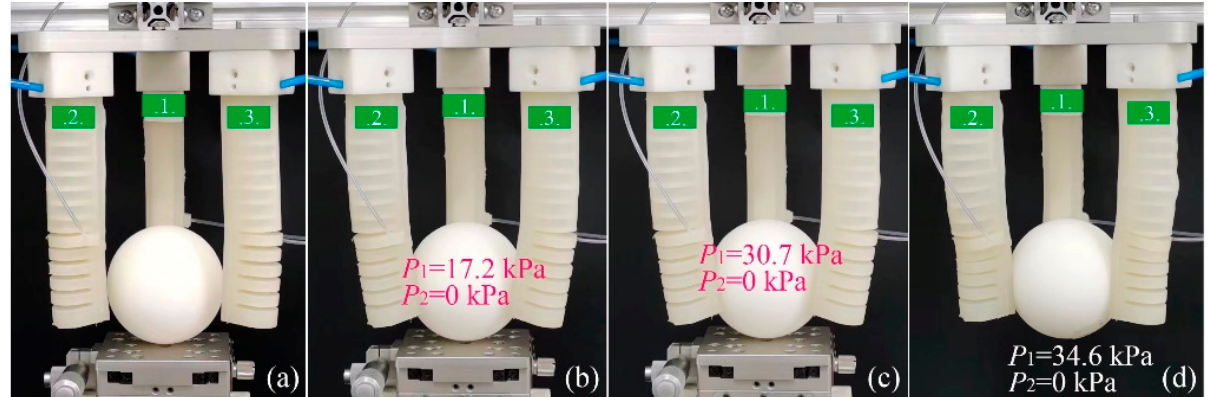
Figure 16. Primary stages of an EG grasping process: ( a ) the original state, ( b ) soft actuators first get in touch with the sphere, ( c ) forming an enveloping grasp with the increase in pressure, and ( d ) realization of a stable PG with a plane contact.